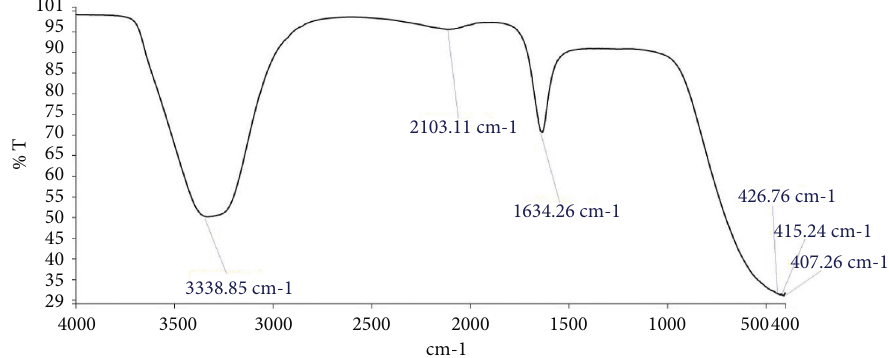
Figure 5: FTIR spectrum of purified Khaya senegalensis gum.